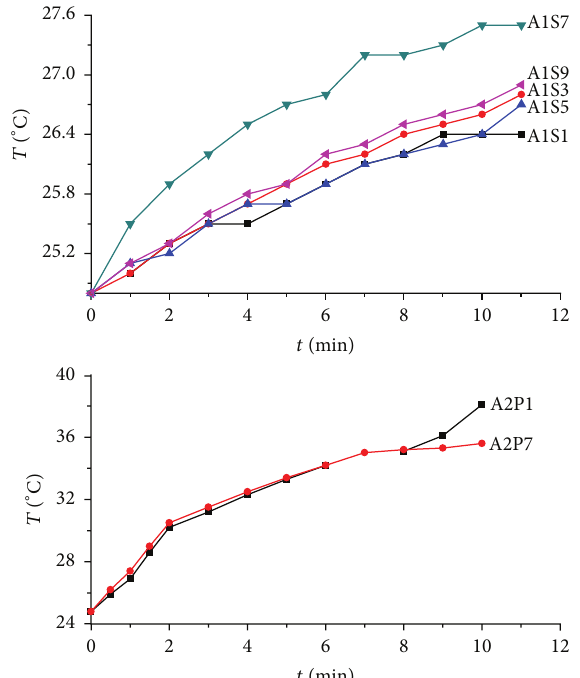
Figure 6: Temperature evolution as a function of time in the hyperthermia